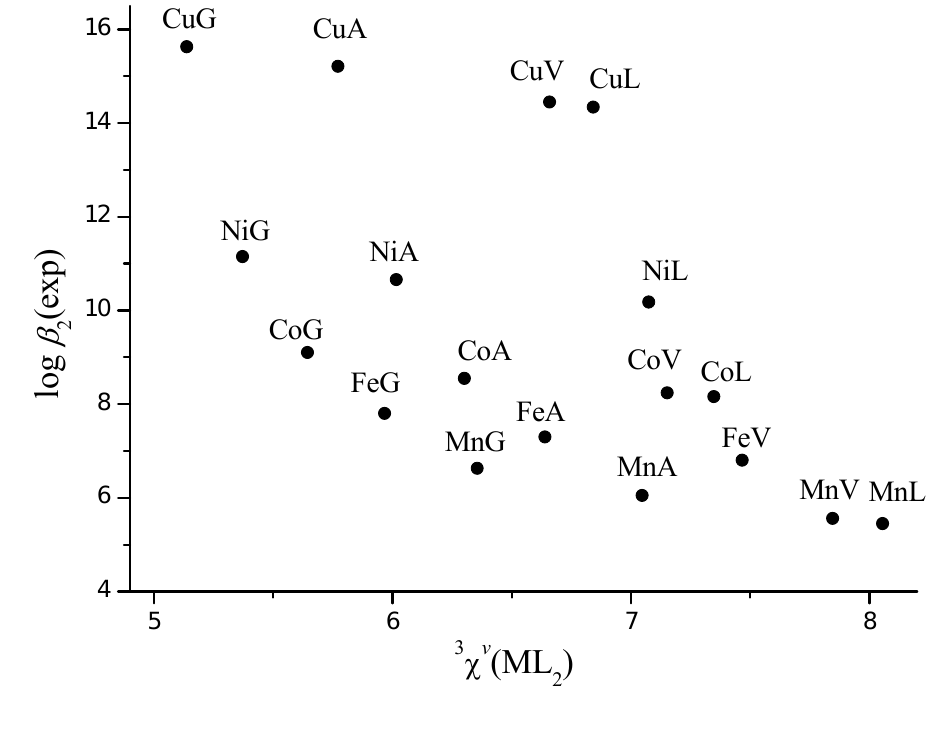
Figure 3. Experimental values of log β vs. connectivity 3 χ v index for Mn 2+ , Fe 2+ , Co 2+ , 2 Ni 2+ , and Cu 2+ complexes with glycine (G), alanine (A), valine (V) and leucine